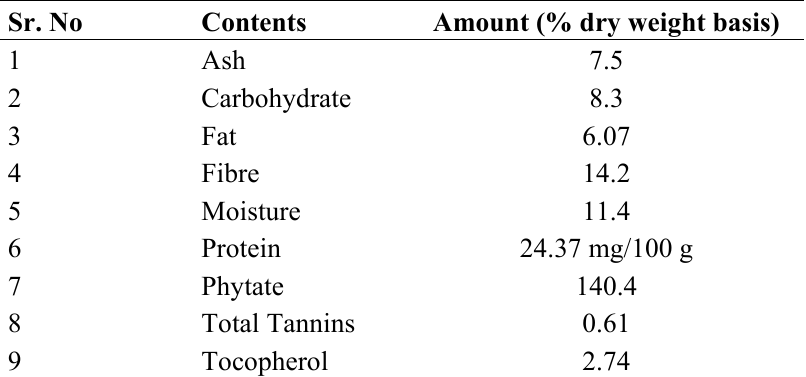
Table 1. Chemical composition of Artemisia annua